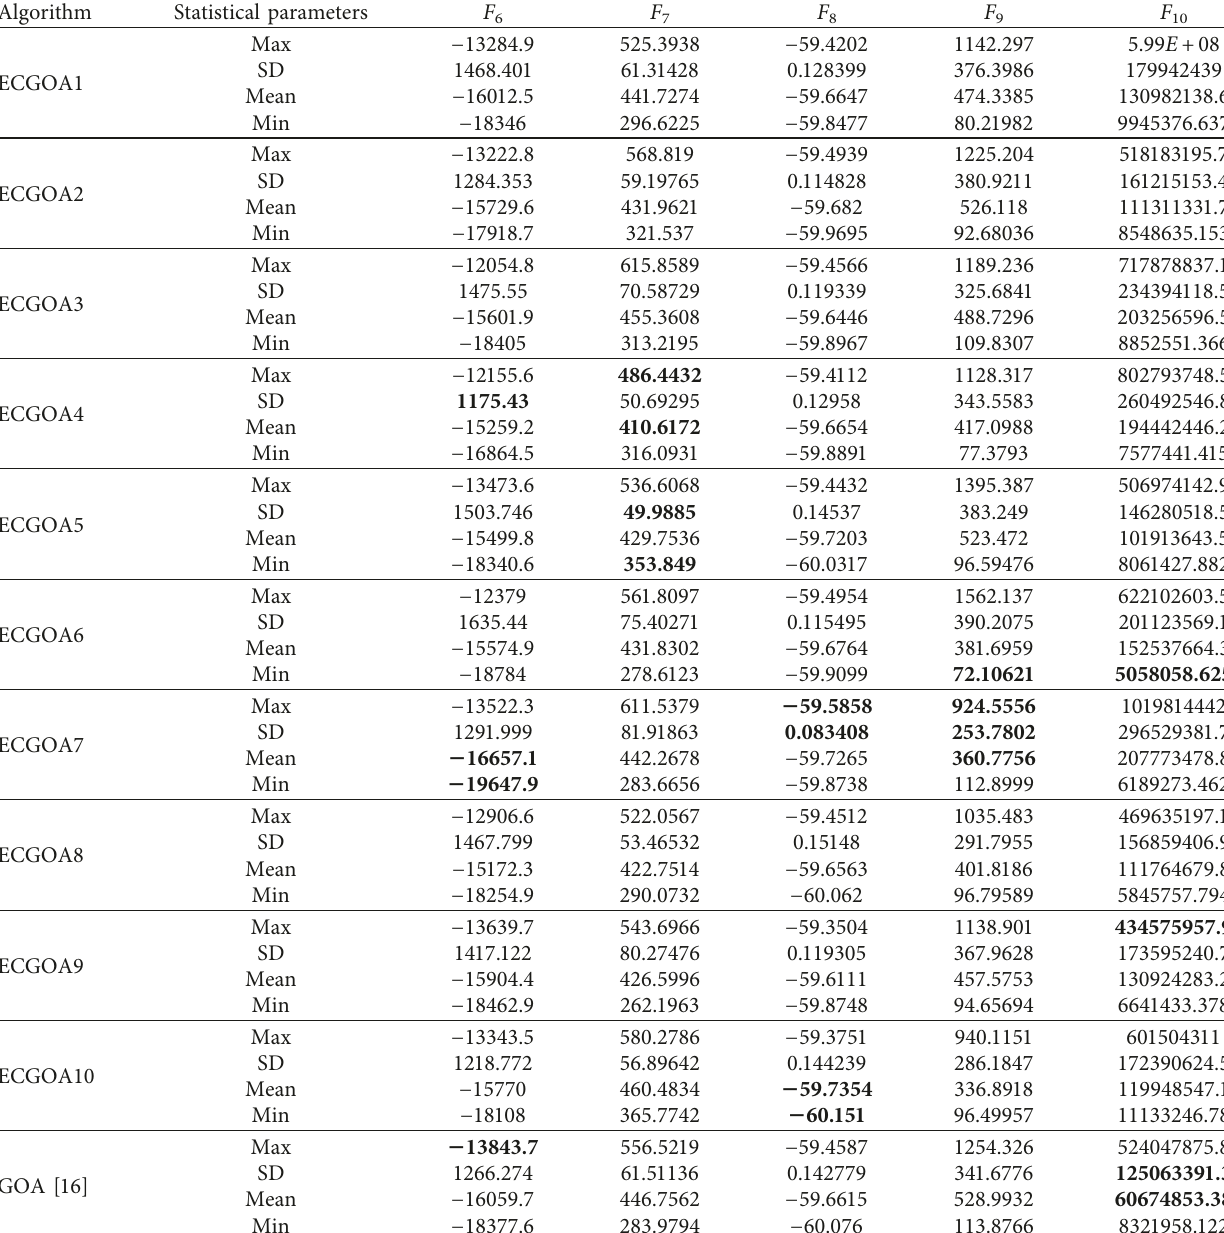
Table 6: Results and comparison of ECGOAs with GOA (50-D) for multimodal functions. Algorithm Statistical